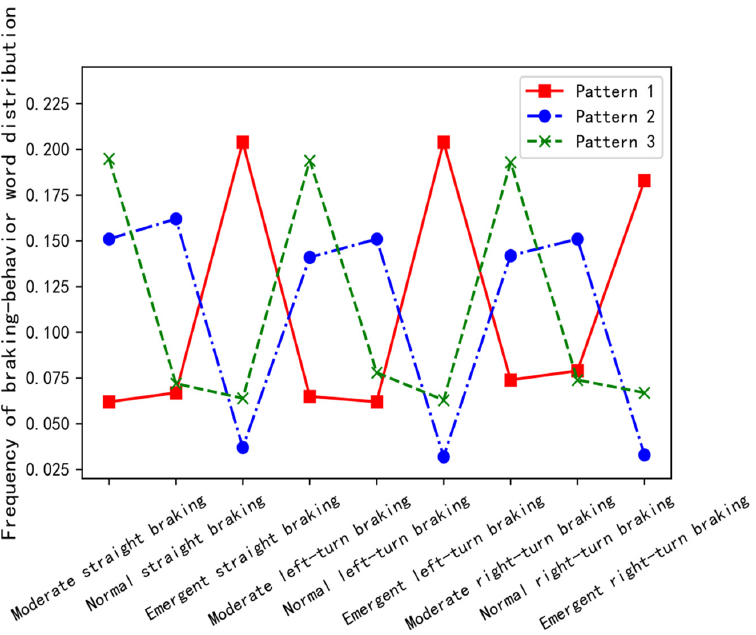
Figure 8. Distribution of different braking behavior words in three braking patterns.